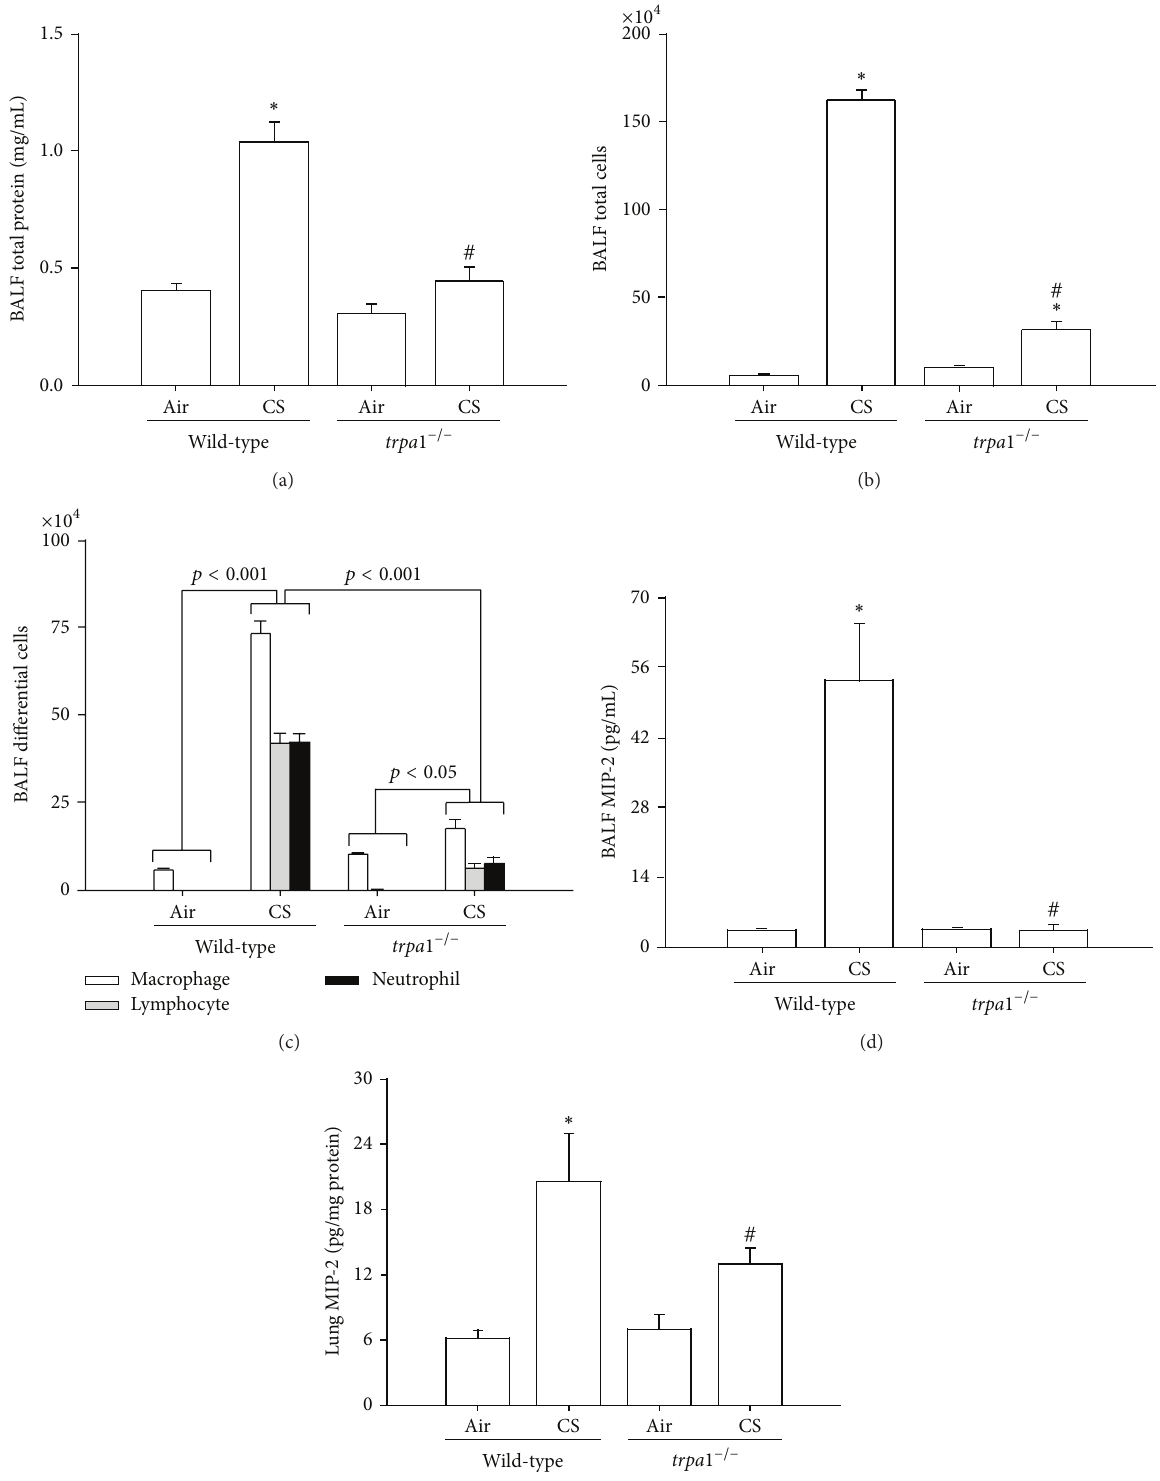
Figure 8: The cigarette smoke- (CS-) induced lung inflammation is alleviated in TRPA1 knockout mice. Mice were chronically exposed to air or CS for 4 weeks. Total protein content (a), total cell count (b), and differential cell count (c) obtained from the bronchoalveolar lavage fluid (BALF) were measured and served as indications of lung inflammation. (d, e) Levels of MIP-2 in BALF and in lung tissues were analyzed by ELISA. Data in each group are mean ± SEM from nine mice. ∗ 𝑝 < 0.05 versus the air-exposure group in both genotypes; # 𝑝 < 0.05 versus the CS-exposure wild-type